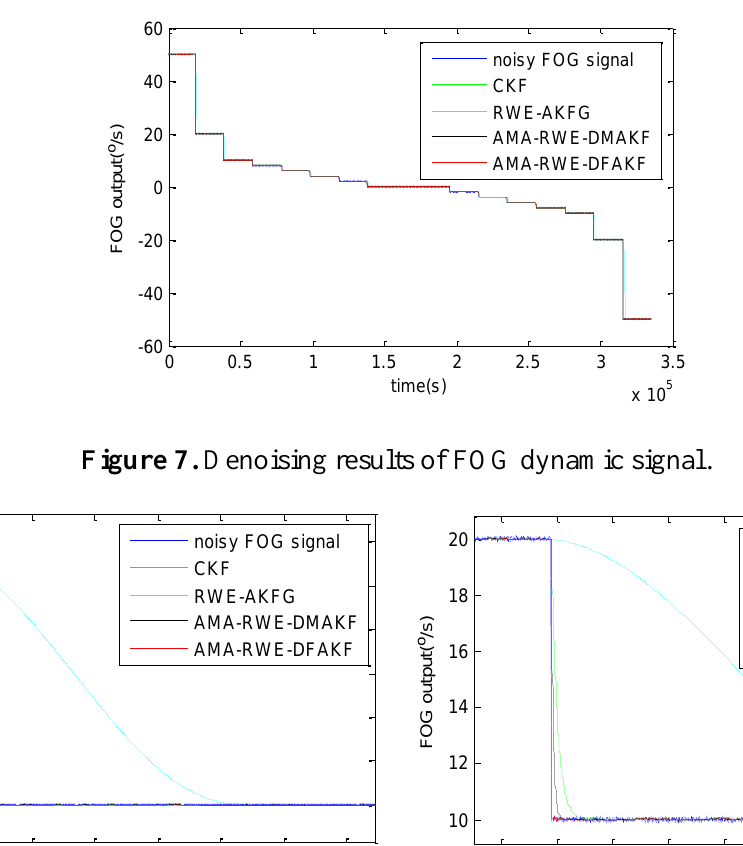
Figure 6. Detected discontinuities using AMA.